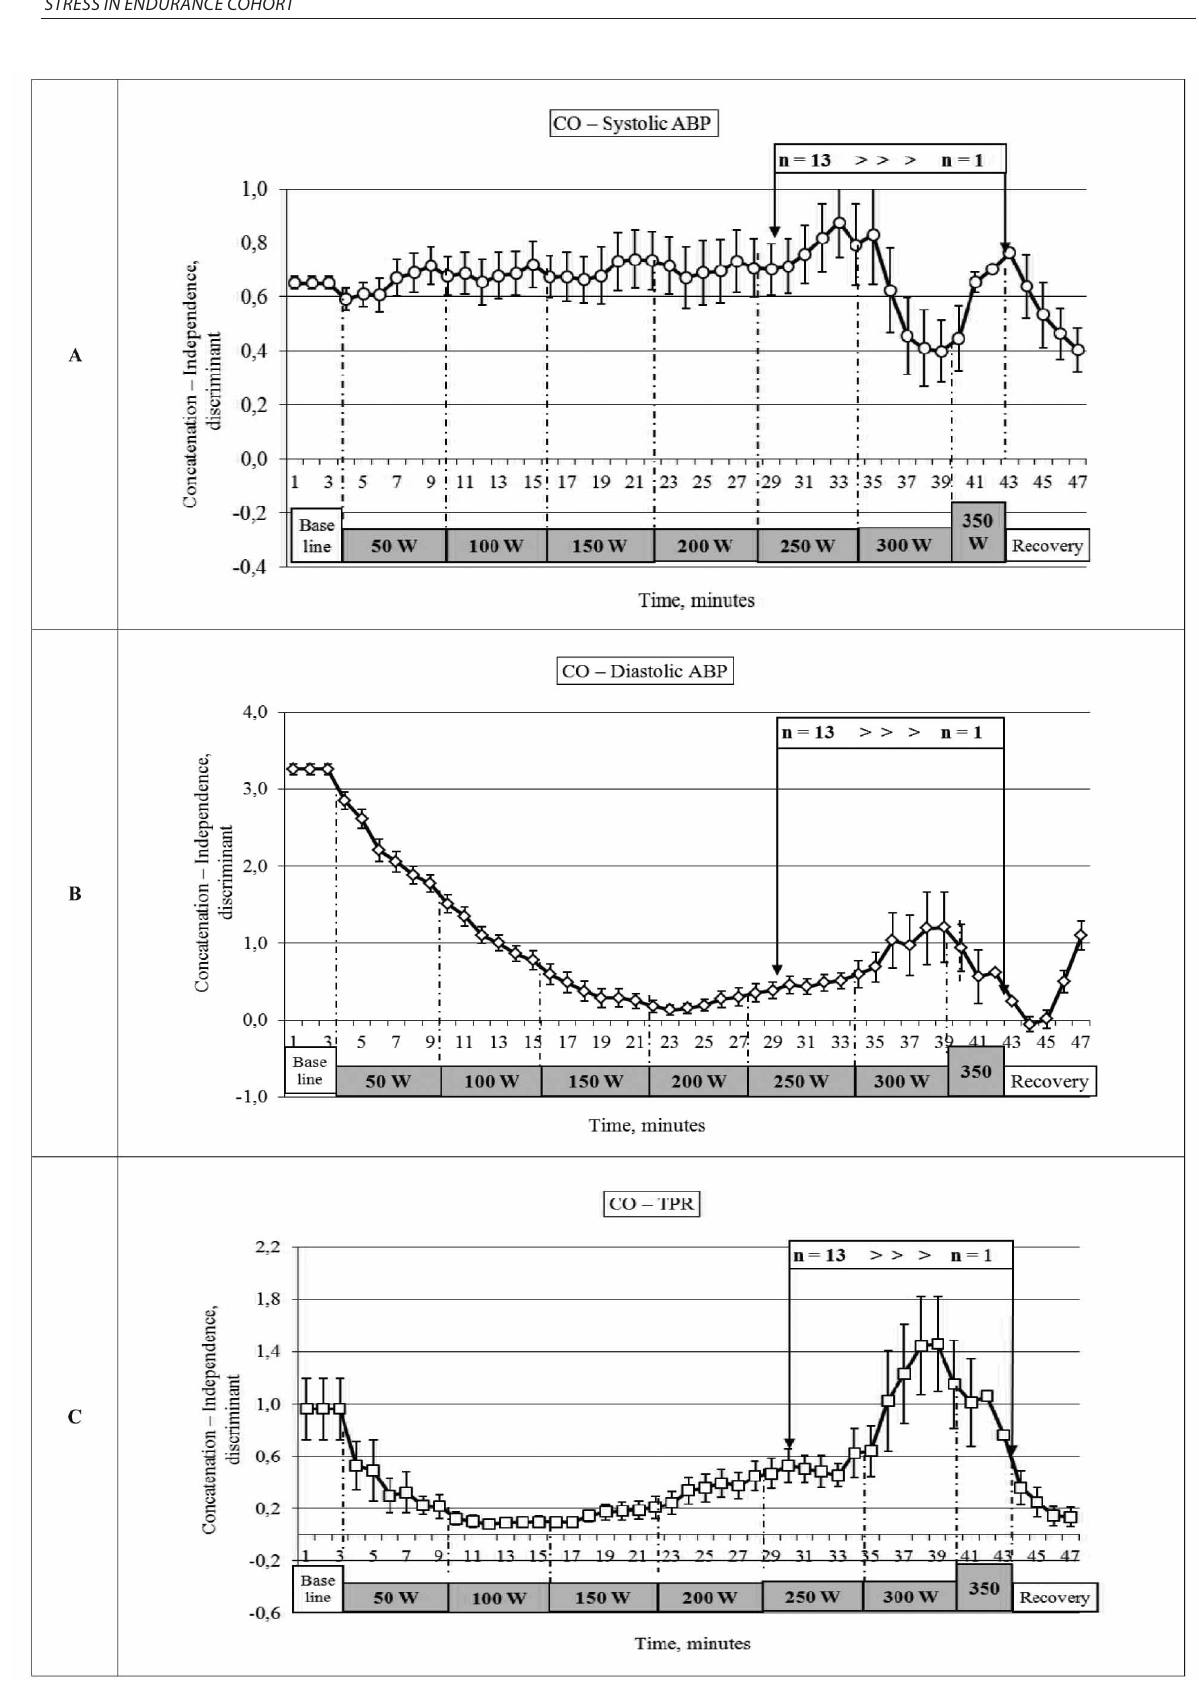
Figure 4. Dynamics of concatenation between cardiac output (CO) and cardiovascular indices changes during incremental exercise stress Note. TPR – total peripheral resistance, > > > – decreasing numbers of participants were able to perform the